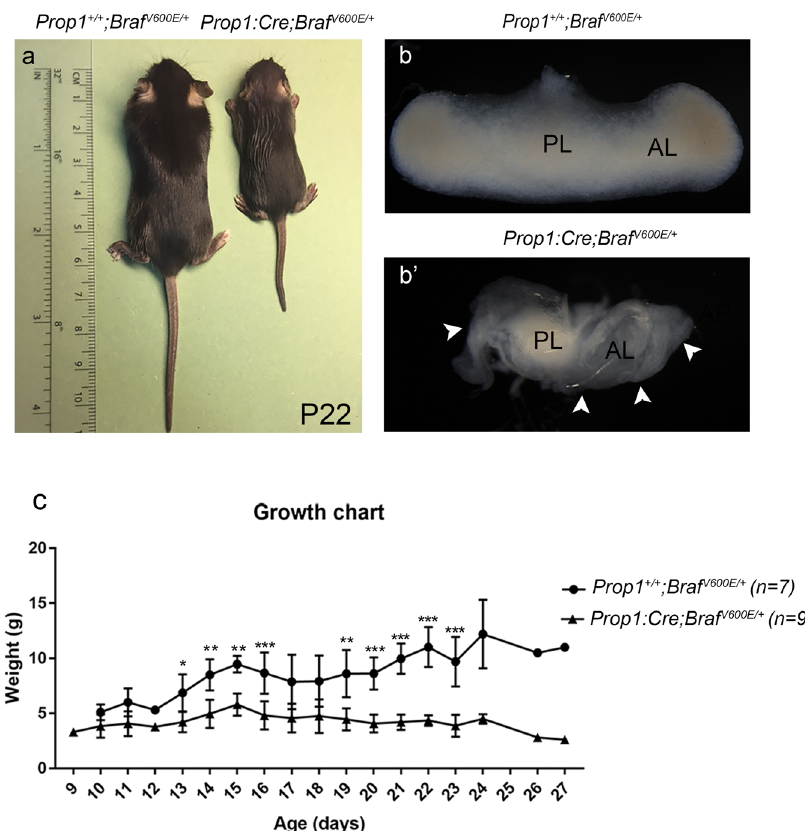
Fig. 3 Expression of Braf V600E in the developing anterior pituitary gland ( Prop1:Cre;Braf V600E/ + ) leads to severe hypopituitarism. a Surviving mutant pups Prop1:Cre;Braf V600E/ + exhibit dwar fi sm and failure to thrive compared to Prop1 + / + ;Braf V600E/ + (Wt) littermates. b , b ′ Whole mount pictures of Prop1 + / + ;Braf V600E/ + Wt ( b ) and Prop1:Cre;Braf V600E/ + mutant ( b ′ ) pituitaries at postnatal day P22 reveal a hypoplastic anterior lobe ( b ′ , AL arrowheads) composed of a rudimentary layer of cells in the mutant mice compared to Wt ( b ). c Growth chart illustrating growth failure of Prop1:Cre;Braf V600E/ + mutants ( n = 9) which die prematurely soon after weaning compared to Wt littermates ( n = 7). *** p < 0.001; ** p < 0.01; * p < 0.05 unpaired two-tailed Student ’ s T -test. Data represented as mean ± SEM of n = 3 – 6 pups per genotype. AL anterior lobe, PL posterior lobe, P postnatal